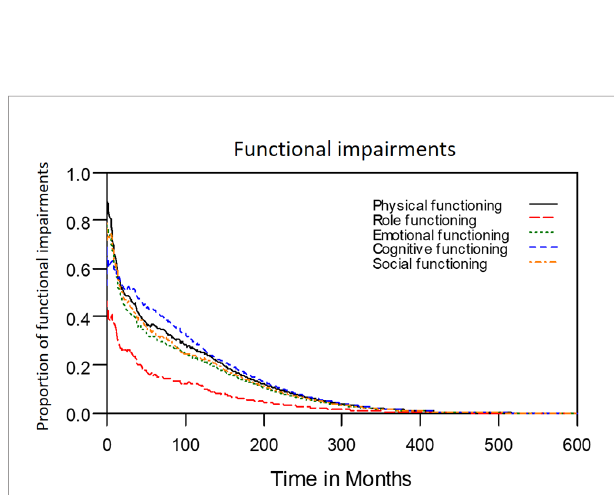
FIGURE 5 | Functional impairments in patients with advanced OSCC. The estimated persistence of functional impairments is represented by the area under the quality-adjusted survival curve. Duration of functional impairments (years): Role — 2.8; Physical — 6.1; Emotional — 5.4; Cognitive — 6.5; Social —